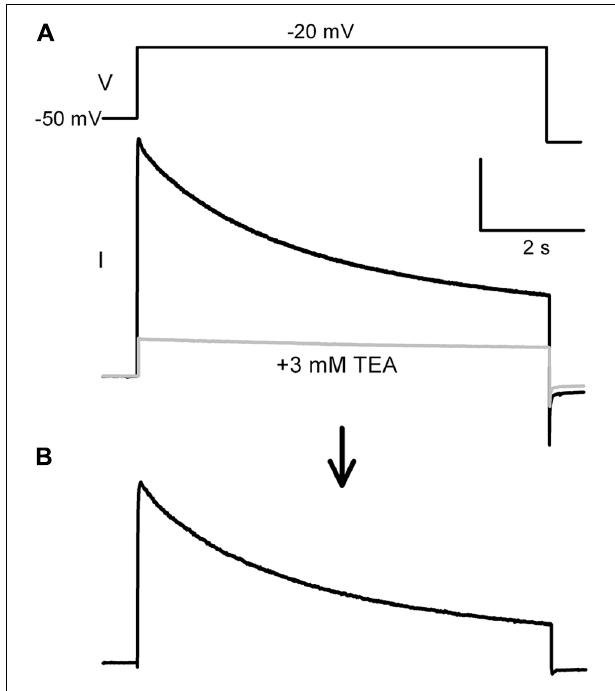
FIGURE 2 | Protocol for measuringTEA sensitive potassium current. (A) The potassium current was measured with a step protocol from a –50 mV prepulse to − 20 mV, as shown in the inset above the trace.This protocol was run a second time with 3 mMTEA (gray trace). (B) Offline subtraction yielded theTEA sensitive current.TheTEA sensitive inactivating current was measured between the peak current and the steady state current end of the